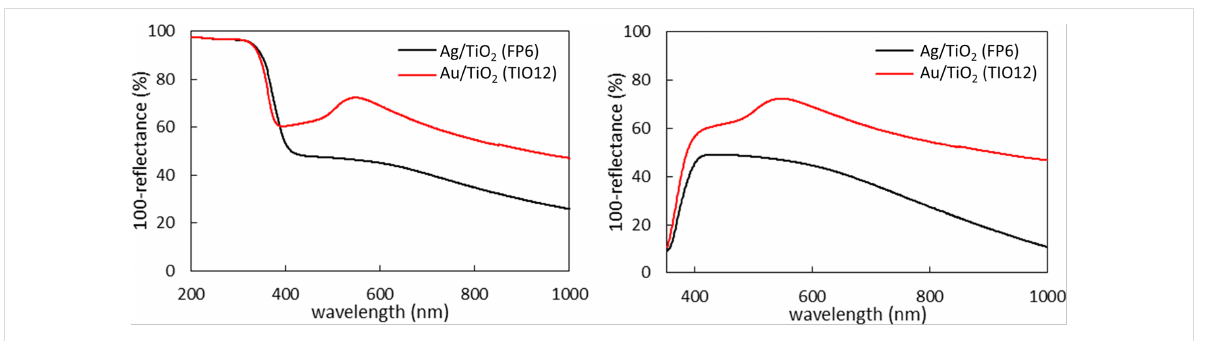
23.7% of mortality after 45 min of treatment with TiO 2 (ST01), TiO 2 (ST41) and TiO 2 (TIO6) samples, respectively. Under irra- diation with visible light, an increase in antibacterial properties was noticed reaching 23.2%, 25.8% and 27.9%,